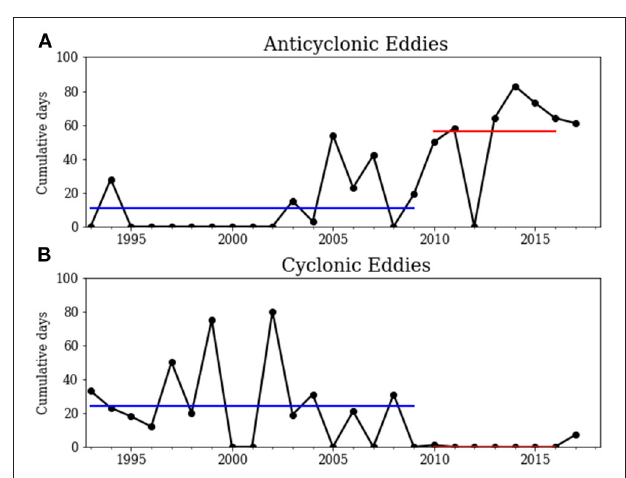
FIGURE 7 | Time series of the total number of days for which eddies remained within the dashed box in Figures 6A–C in summer (JAS) each year. For example, if one eddy remained within the box for 30 days and another eddy remained in the box for 20 days during JAS a certain year, the total cumulative days in the year is 50. (A) For anticyclonic eddies. (B) For cyclonic